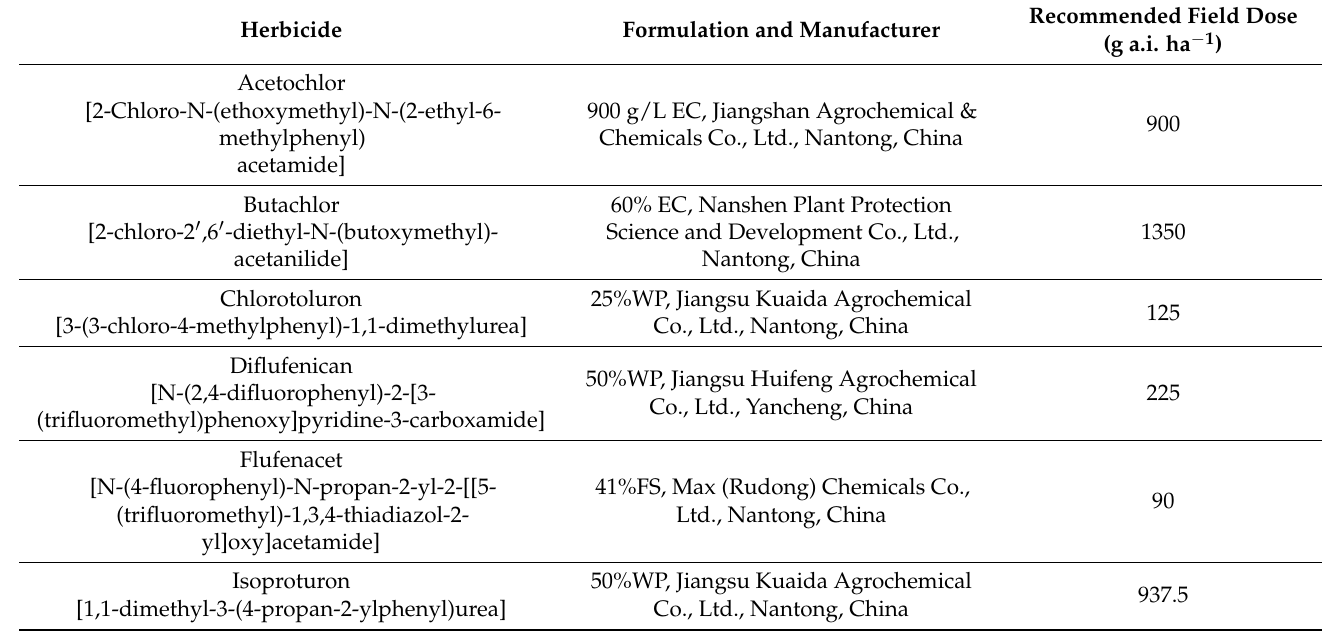
Table 1. Detailed information of PRE herbicides used in this study. Formulation and Manufacturer